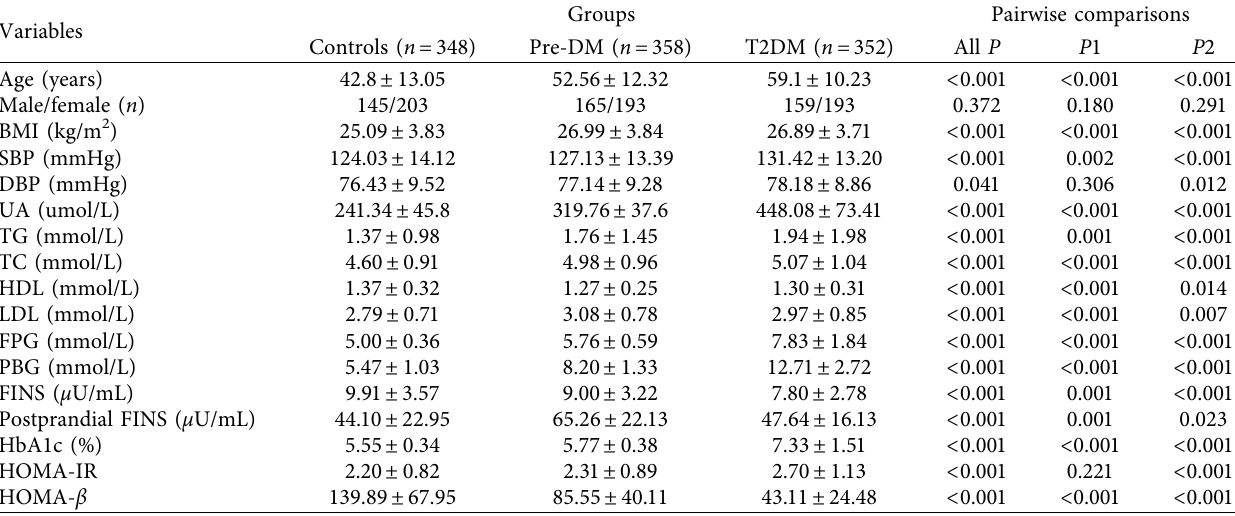
Table 1: Comparison of the general data and biochemical parameters for the control, prediabetic, and type 2 diabetic groups. Groups Pairwise comparisons Variables